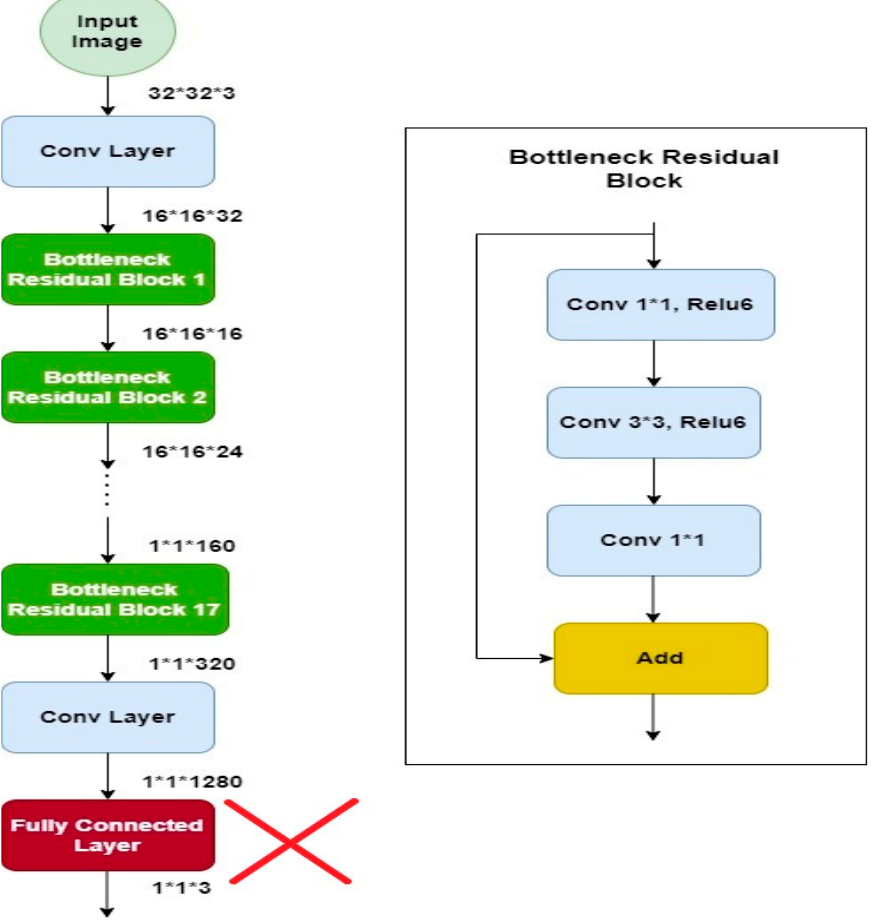
Figure 7. Mobilenetv2